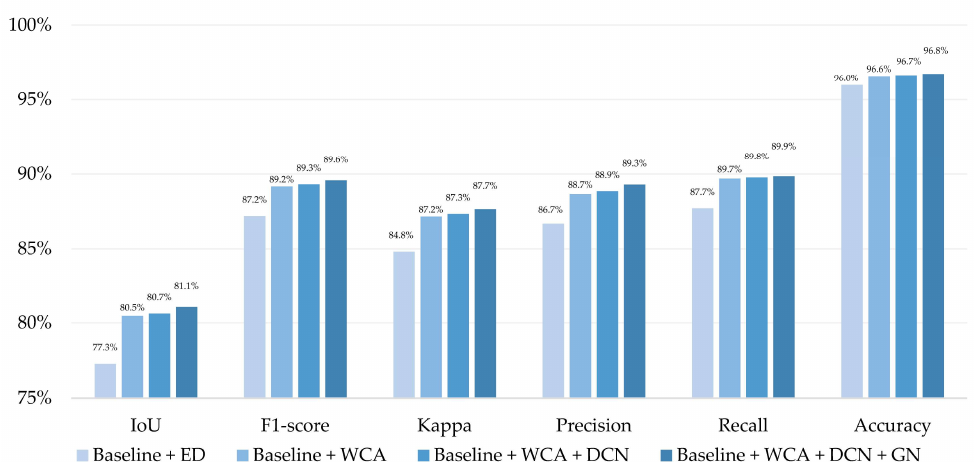
Figure 12. Ablation experimental results obtained on the Inria dataset.